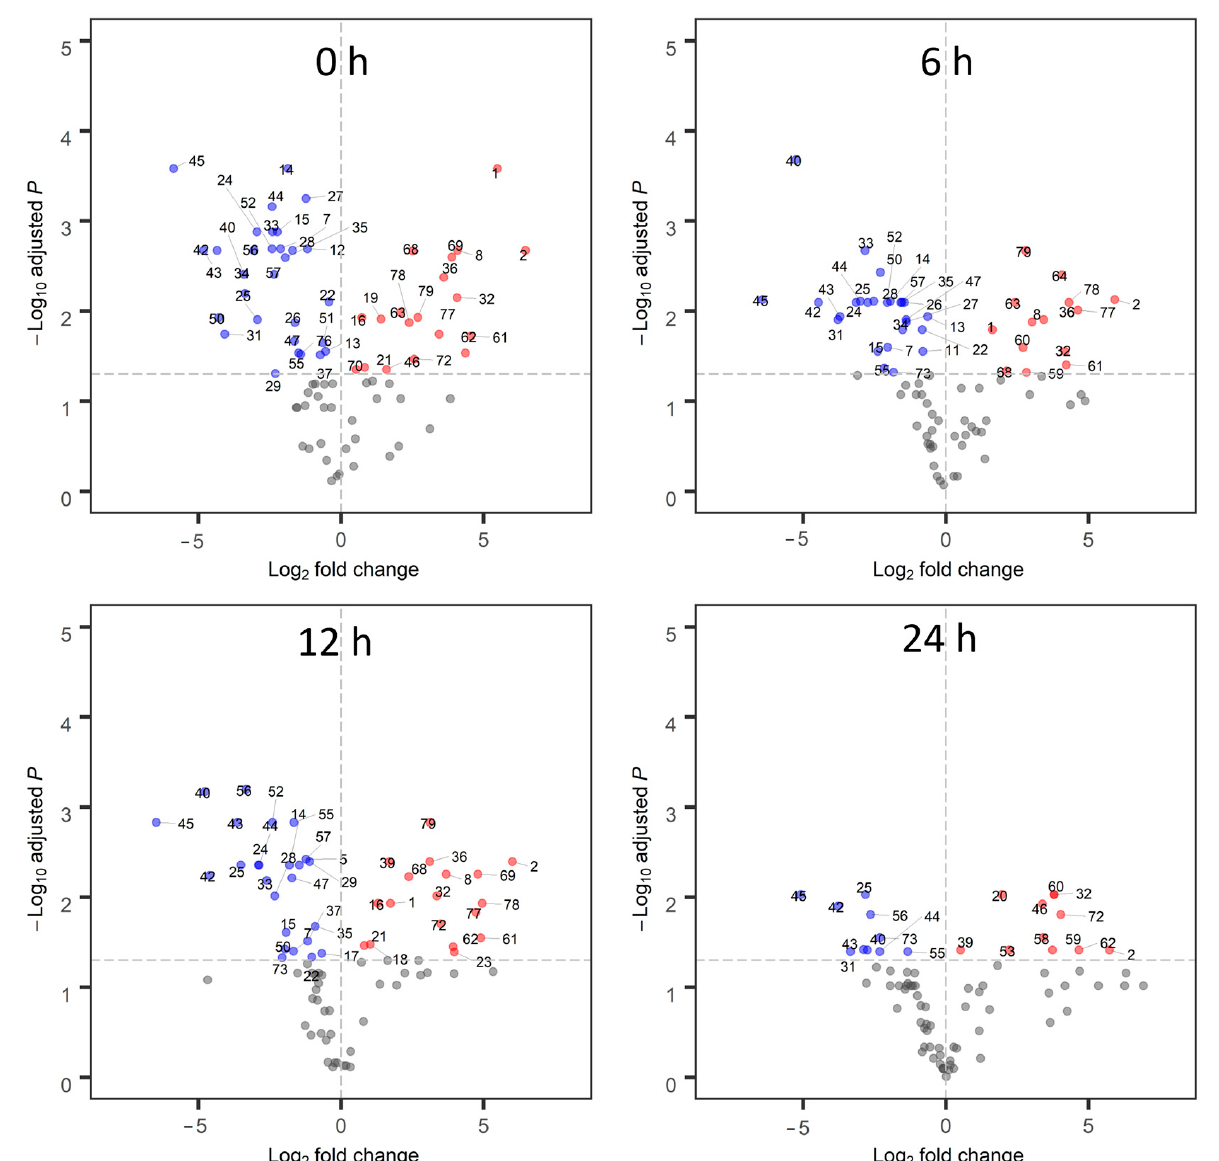
Figure 4. Volcano plots showing significantly changed metabolic features between hy- poxia/reoxygenation treated and control plants at each time point. Red dots indicate significantly increased metabolites, and blue dots indicate significantly decreased metabolites with an adjusted p -value after Benjamini–Hochberg correction to control the false discovery rate at 0.05. The data points in each plot represent 80 metabolic features described in Supplemental Dataset S1.